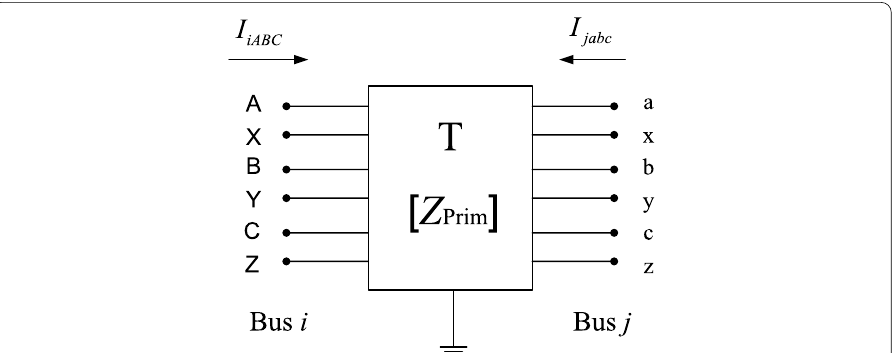
Fig. 3 A three-phase transformer; It describes the arrangement of 12 coins of a three-phase